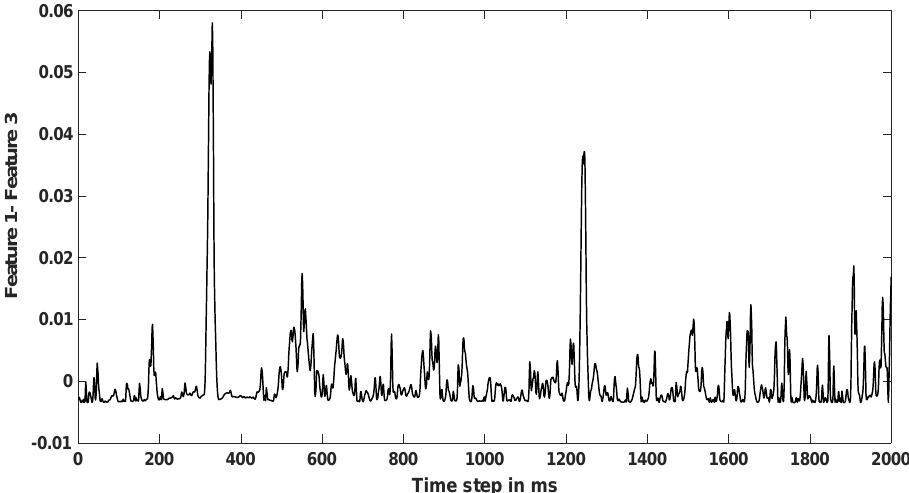
Figure 7. Difference between Feature 1 (Sum of absolute values) and Feature 3 (Standard deviation) for one example